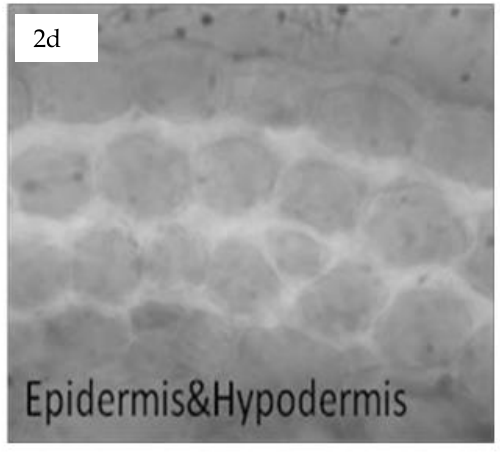
Figure 2: The transverse section of the petiole leaf of N. arbour-tristis . Figure 2a represents transverse section of petiole, 2b, 2c 2d represents enlarged portion of petiole